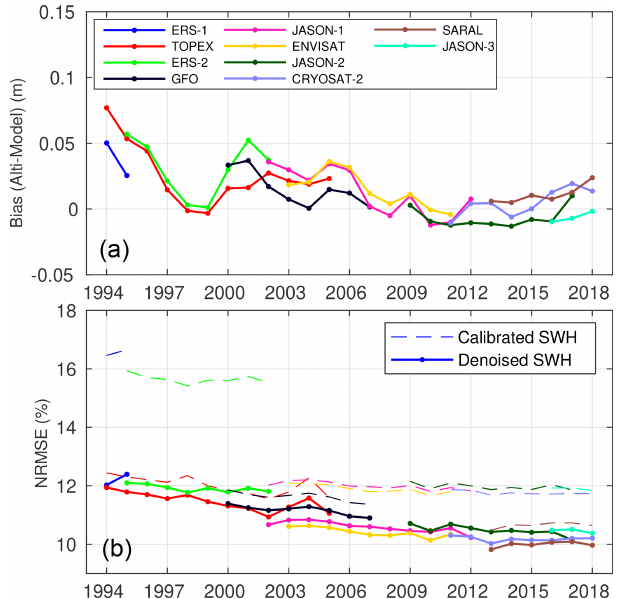
Figure 11. Time series of mean global bias (a) and mean global NRMSE (b) between Sea State CCI dataset v1 and WW3 model outputs forced with ERA5 wind fields (see Sect. 2.3). The thin dashed lines in (b) represent the results obtained for the calibrated SWH before denoising was